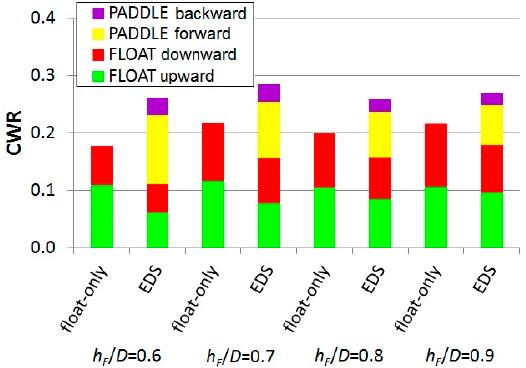
Figure 15. CWR distribution among float and paddle, and motion phases of each body. Wave A.